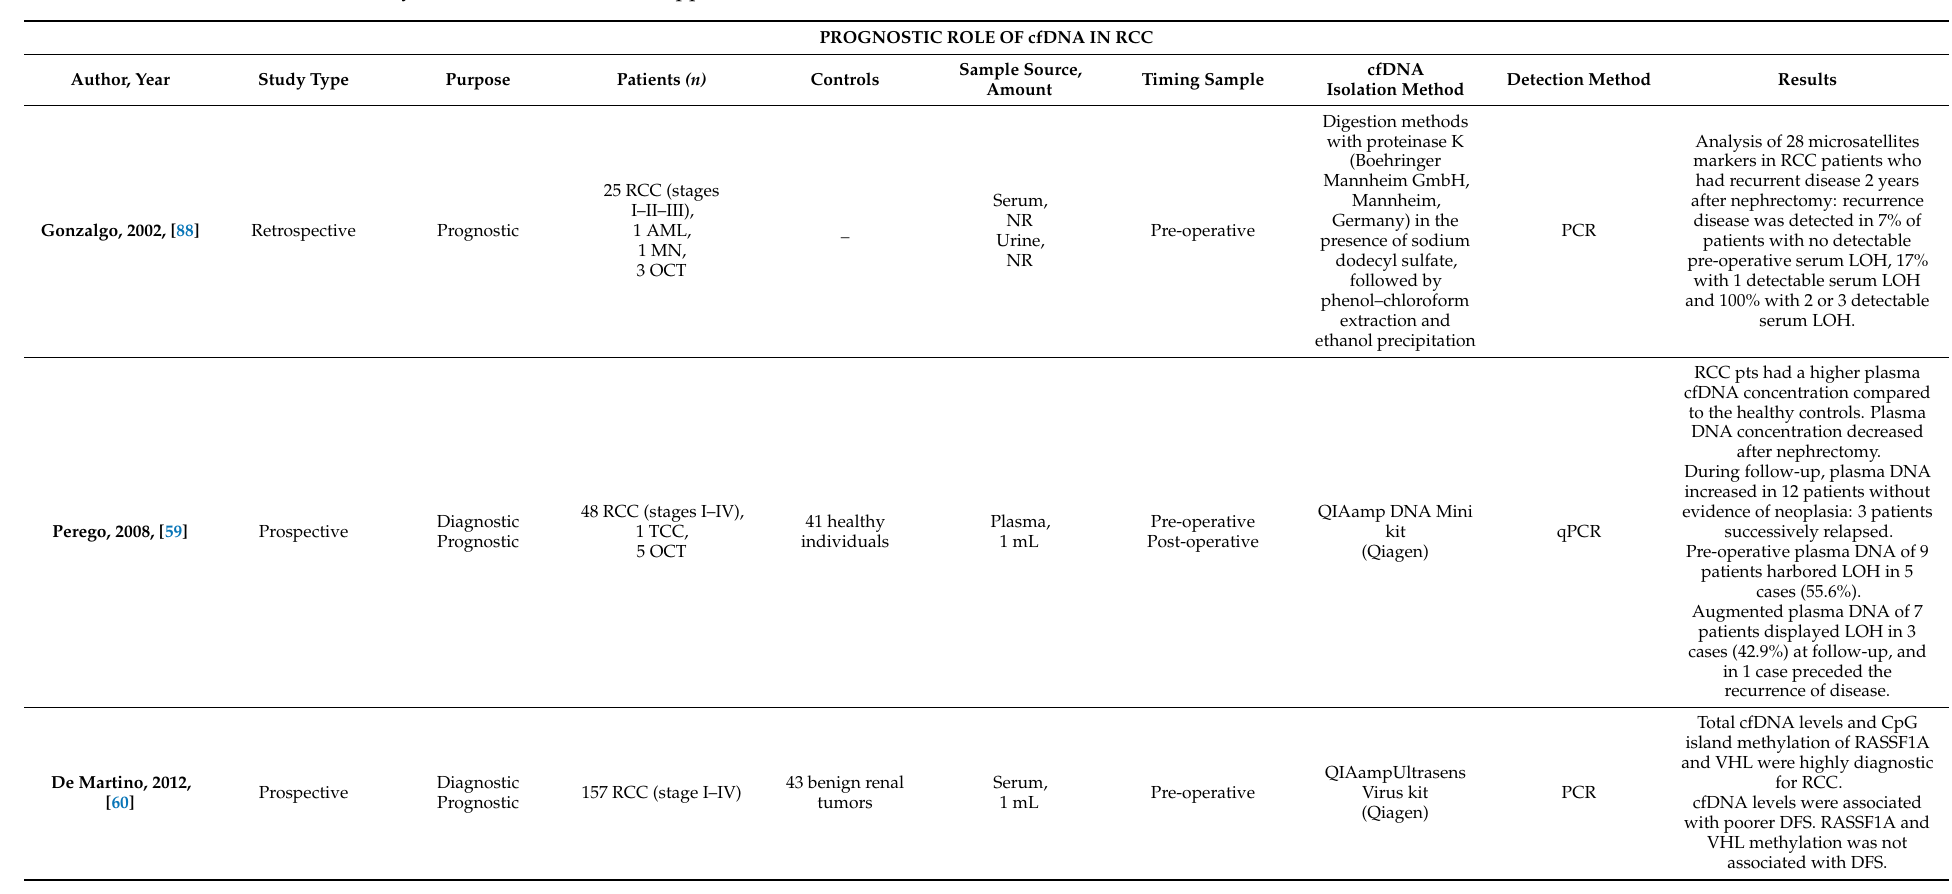
Table 4. Summary of the studies evaluating the prognostic role of circulating cell-free DNA (cfDNA) in renal cell carcinoma (RCC). LOH: loss of heterozygosity; mRCC: metastatic Renal Cell Carcinoma; NF1: neurofibromatosis type 1 gene; OS: overall survival; p14 ARF: auxin response factors p14; PCR: polymerase